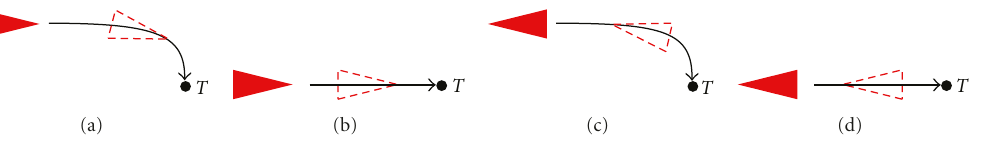
Figure 6: Behavior specified by the reference vector field of Figure 5.